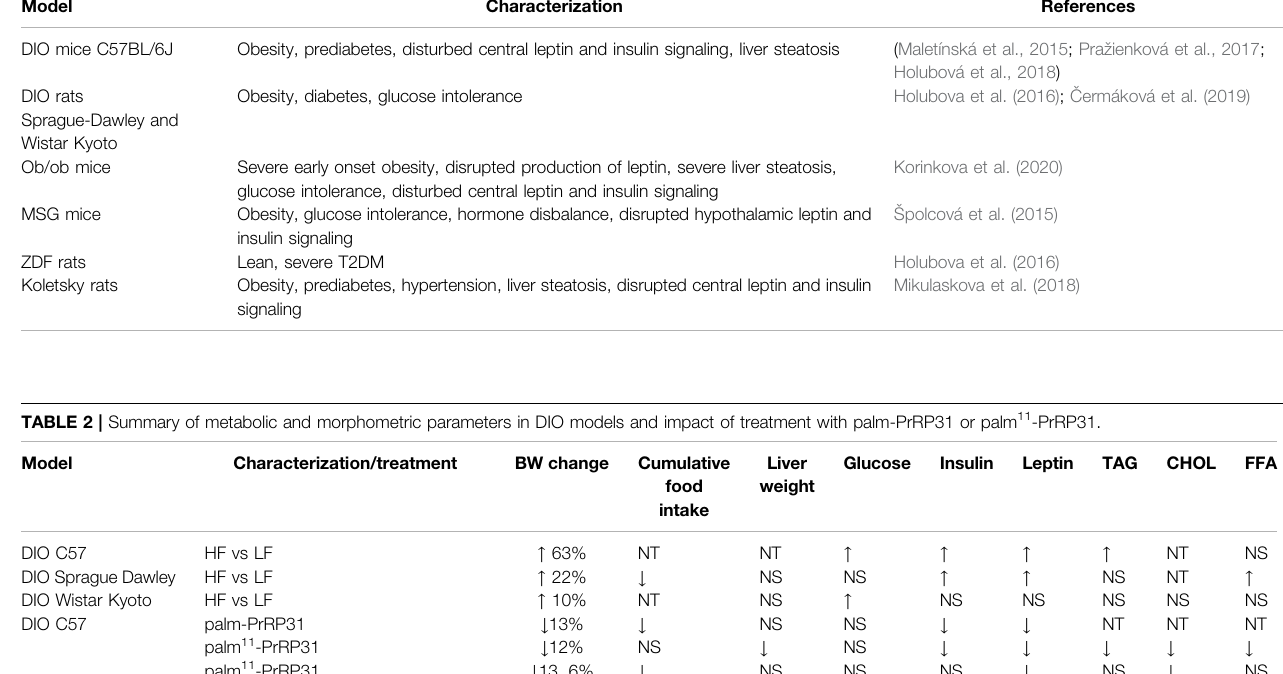
TABLE 1 | Characterization of rodent models used in studies of interventions with palmitoylated PrRP31 analogs. Model